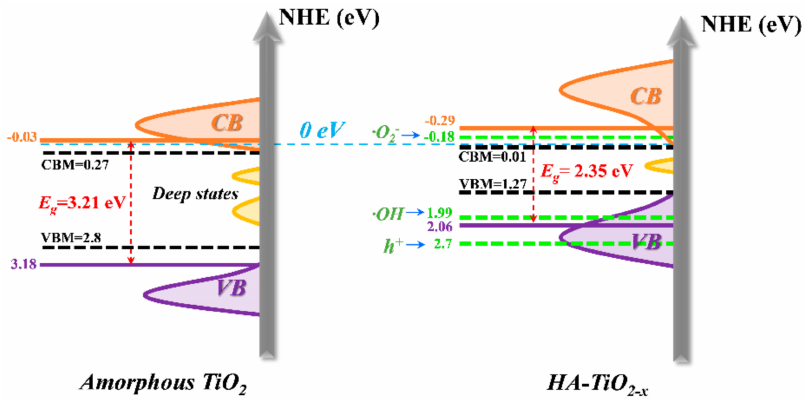
Figure 7. The schematic illustration of bandgap structure of amorphous TiO 2 and HA-TiO 2 − x . The bandgap of amorphous TiO 2 was measured from Figure S3 which was 3.21 eV and well accorded with theoretical value. As shown in Figure 7 (left), two continuous deep midgap trap states filled in the bandgap, which could have originated from large bulk voids or long-range lattice disorder in amorphous TiO 2 [43]. As mentioned in